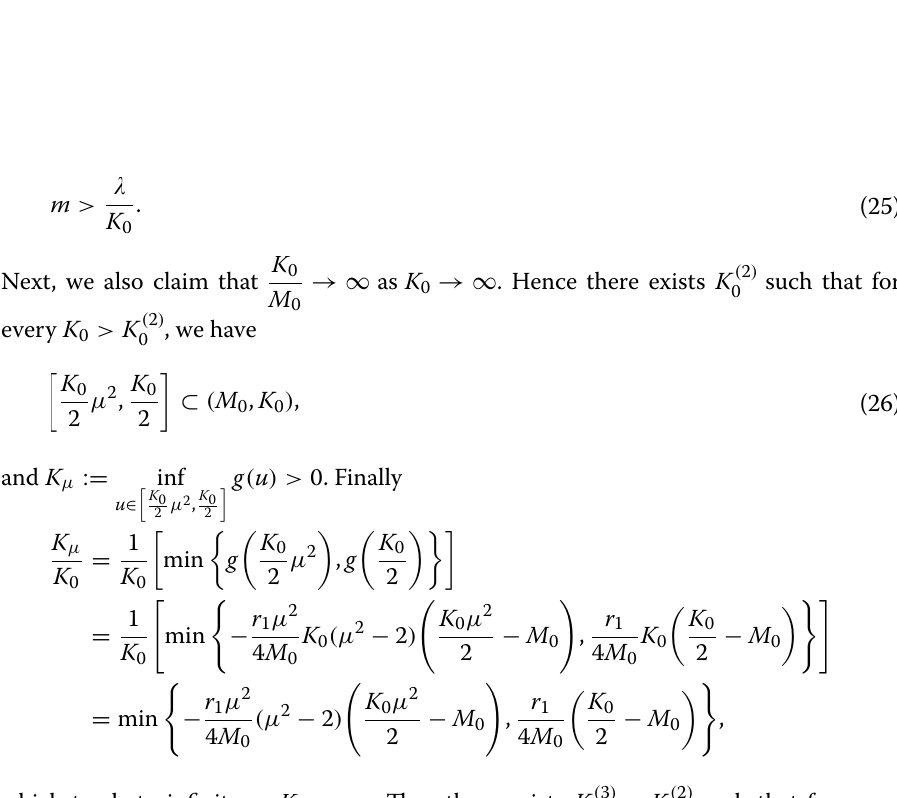
Fig. 5 Growth rate function uf ( t , x , u ) with weak Allee effect for M d 1.0 and r ( x ) =